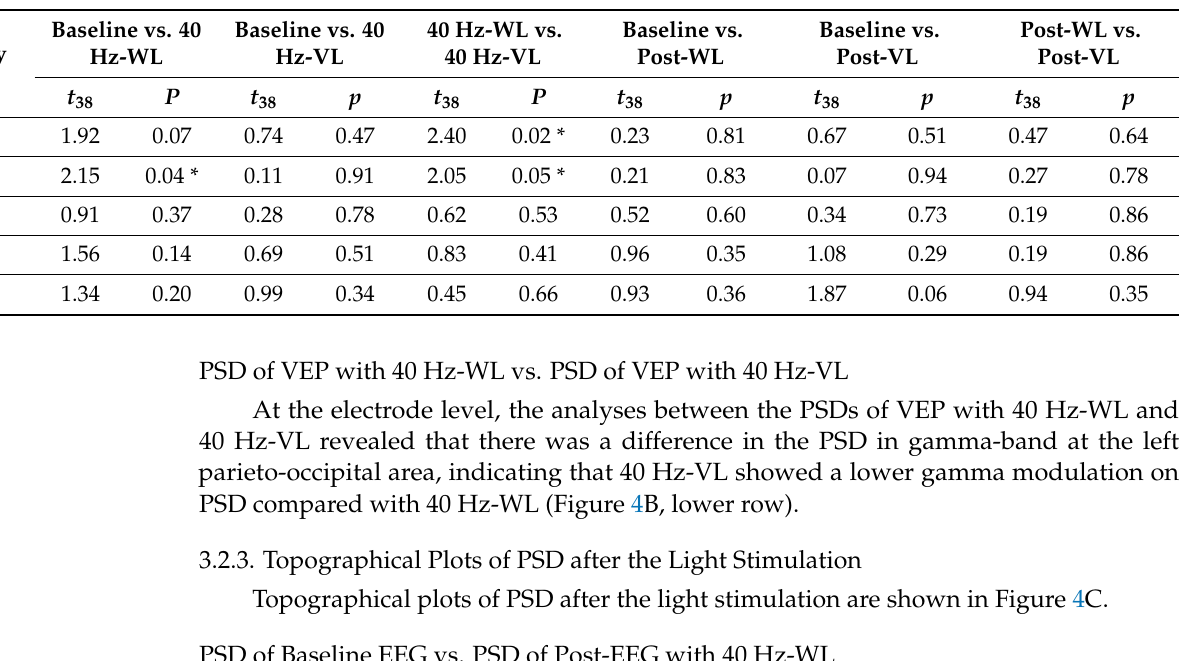
Table 1. Summary of statistical analysis results comparing all electrode averaged PSD between each condition for each frequency band (* p < 0.05). Baseline vs. 40 Frequency Band